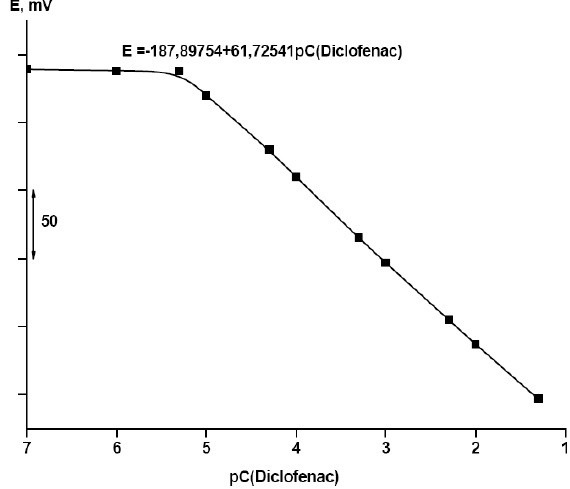
Fig. 5 Calibration plot for the proposed diclofenac selective electrode with optimized membrane composition (membrane 1; pH 6.5).